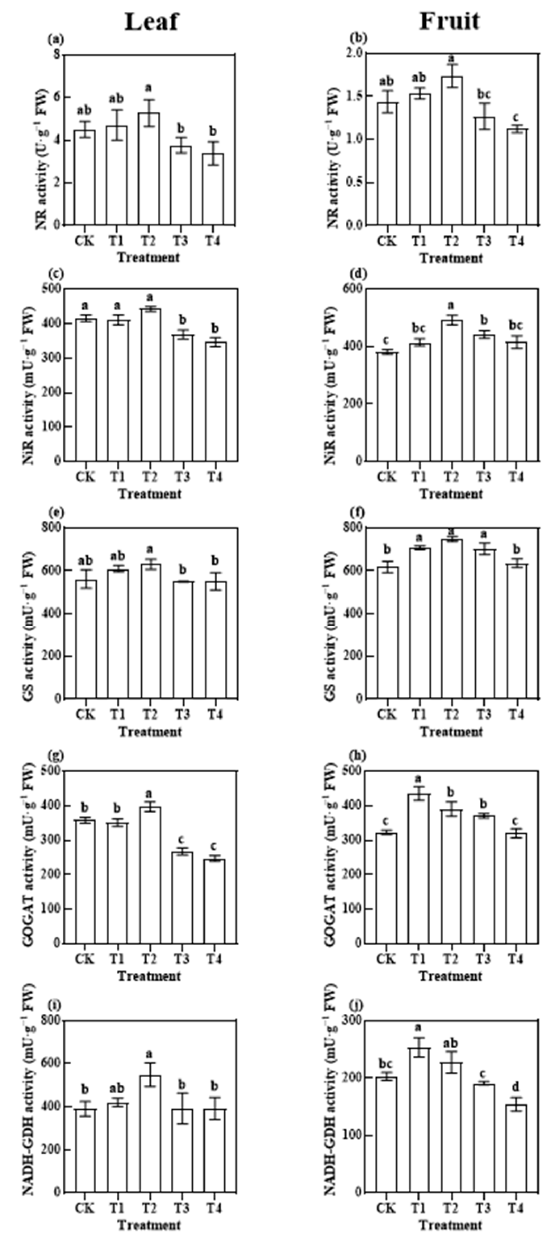
Figure 4. Effects of reduced fertilisation before harvest on the activities of N metabolism-related enzymes in plants. At the peak fruiting stage (the day of the fourth fruit harvest), samples were taken to determine the activities of N metabolism-related enzymes in leaves and fruits. NR ( a , b ) nitrate reductase; NiR ( c , d ) nitrite reductase; GS ( e , f ) glutamine synthase; GOGAT ( g , h ) glutamate synthase; NADH-GDH ( i , j ): NADH-dependent glutamate dehydrogenase. The bar size was mean ± SE (n = 3). Different letters indicated significant differences between treatments at p of 0.05 according to Tukey’s multiple range test. With no fertiliser reduction as the control (CK), the T1, T2, T3 and T4 treatments represented 20%, 40%, 60% and 80% reduction in fertiliser application from 0 to 6 days before each harvest,